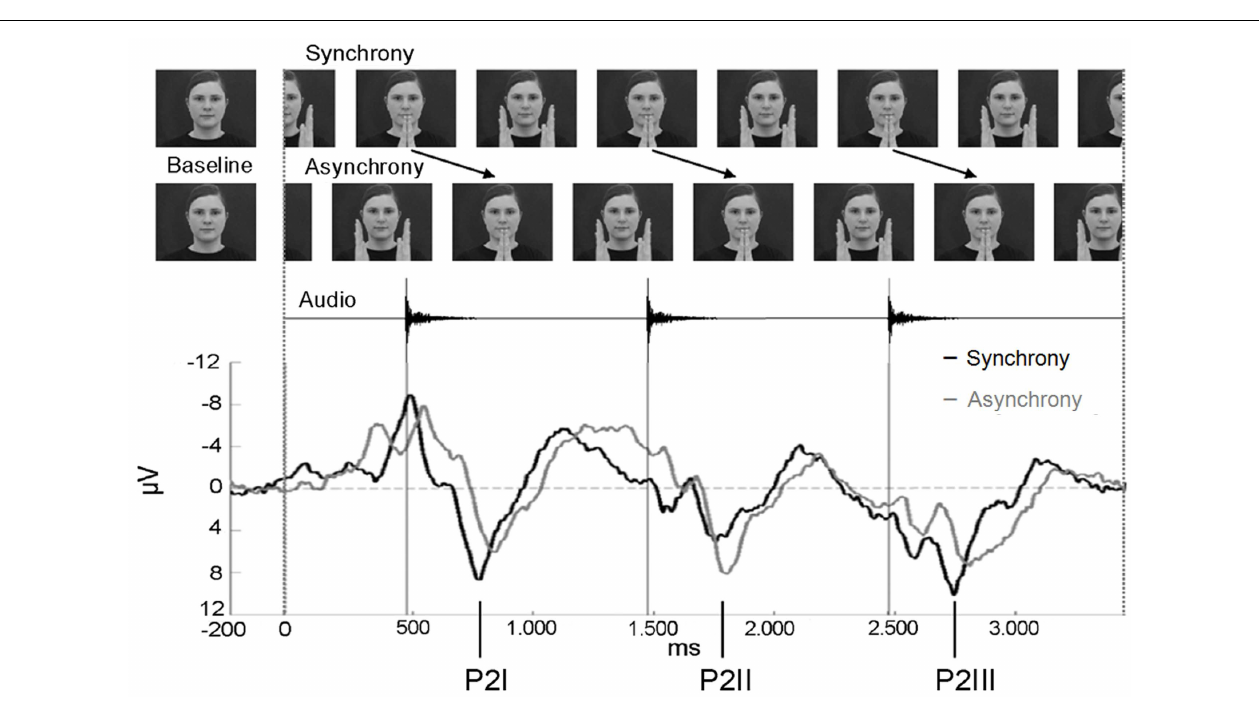
across anterior electrodes for the purpose of illustration ( n = 15). Note that the auditory onset was at the same point in time in both conditions.The three P2 components elicited during the entire epoch are labeled P2I, P2II, and